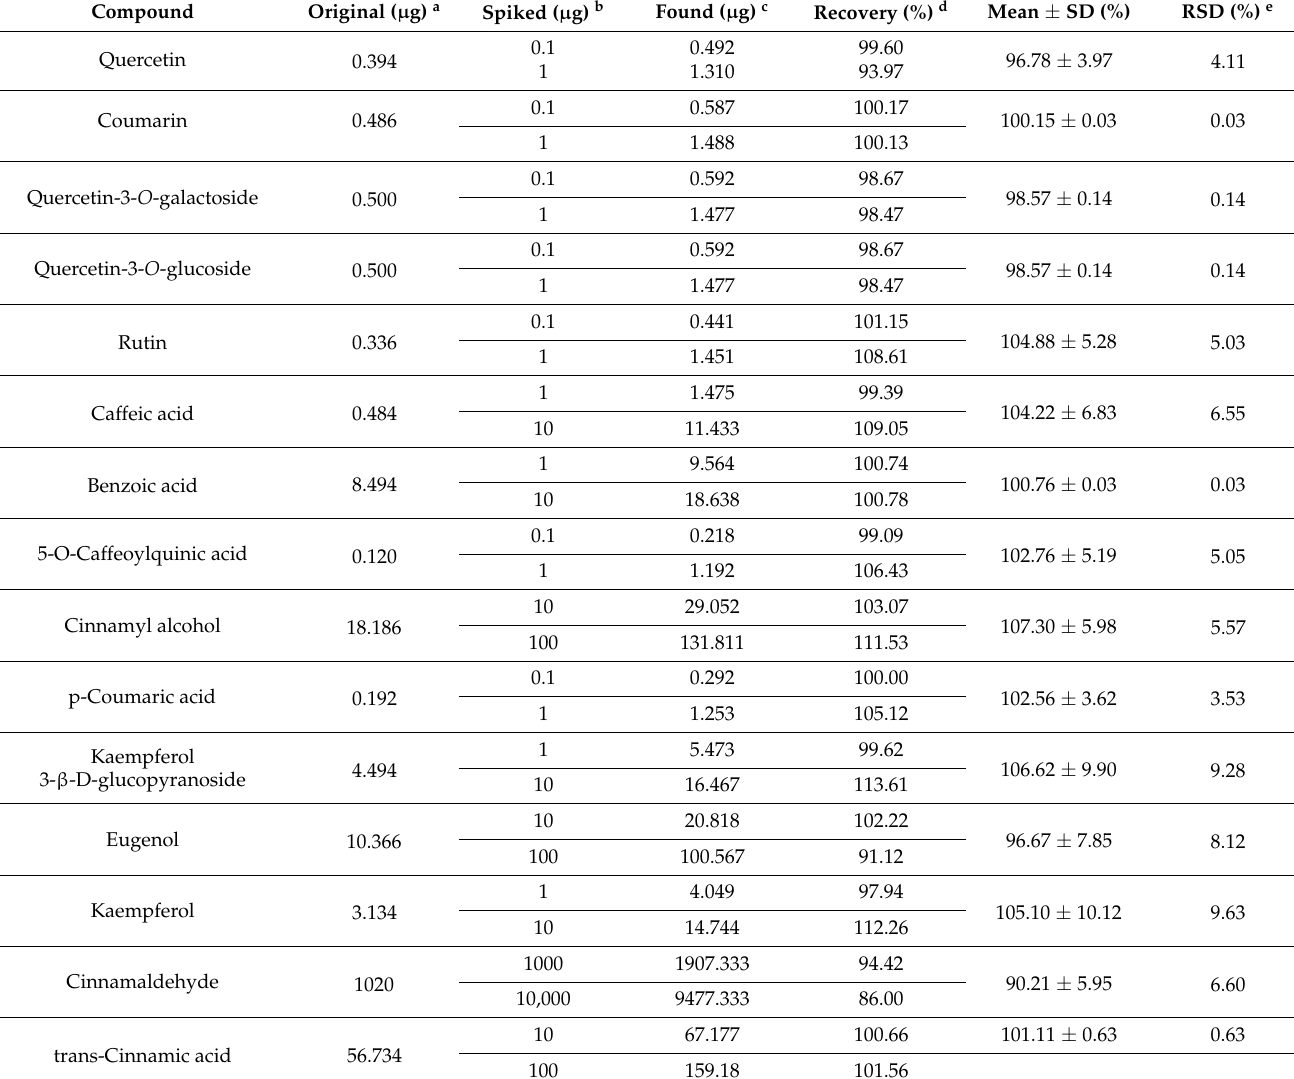
Table 6. Recovery of cinnamaldehyde and the other bioactive compounds in C. osmophloeum leaves by